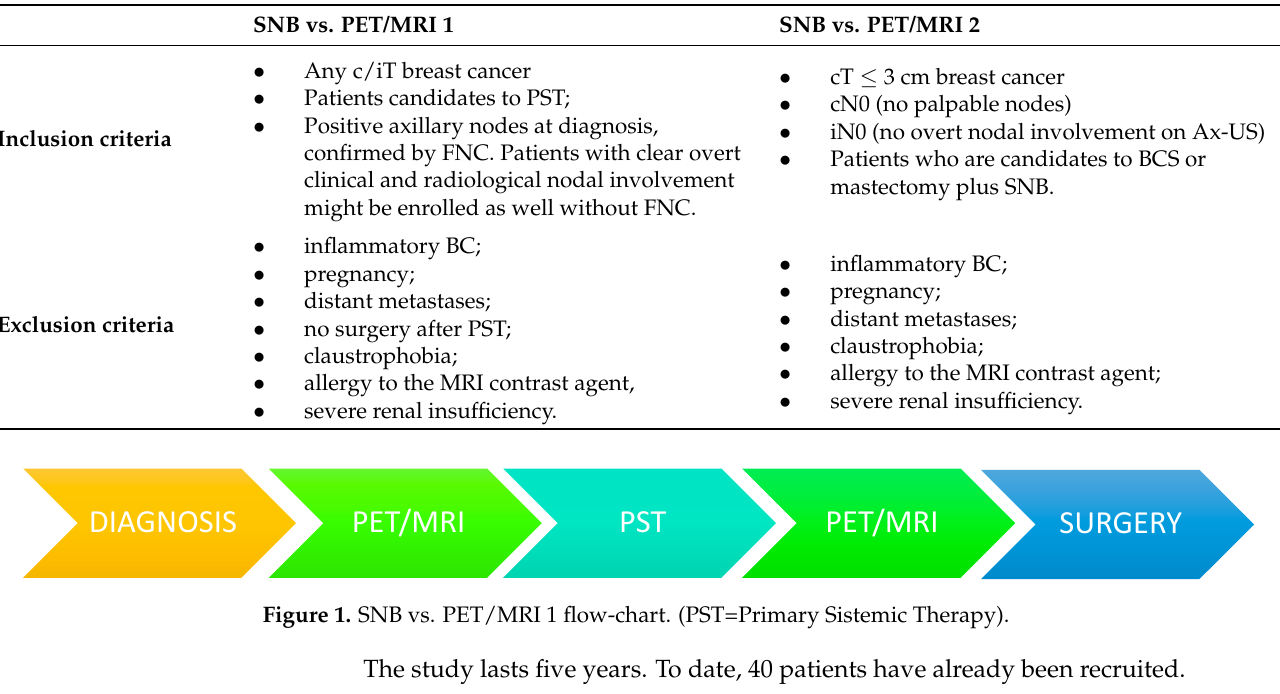
Table 4. Italian SNB vs. PET/MRI trials: inclusion and exclusion criteria. (FNC = fine-needle cytology, PST = primary systemic therapy, BC = breast cancer, MRI = magnetic resonance imaging, Ax-US = axillary ultrasound, BCS = breast conserving surgery, SNB = sentinel node biopsy).